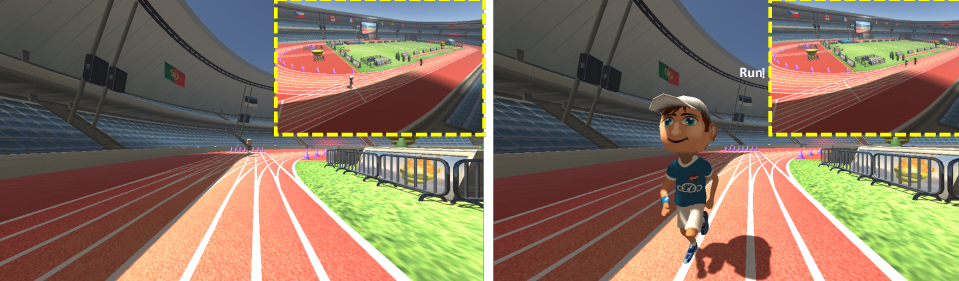
Figure 4. Third-person viewpoint (as shown with a yellow window) for non-HMD users. The figure shows that the HMD user(the character with the blue shirt) is facing toward the forward direction of the non-HMD user’s head. The left image shows both the users at a substantial distance. The right image shows both the users in proximity, and the text information provides hints to the non-HMD